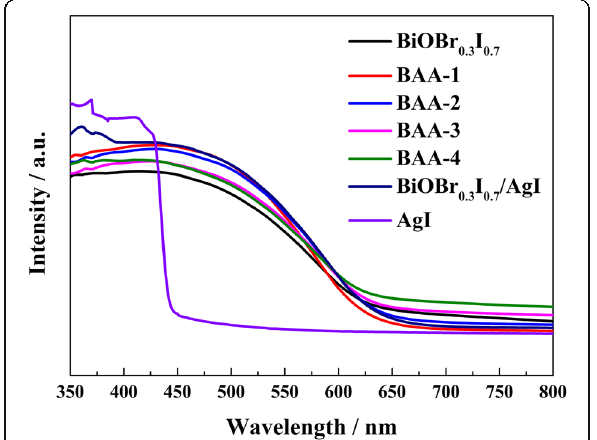
Fig. 3 UV – vis DRS spectra of BiOBr 0.3 I 0.7 , BAA- x , and BiOBr 0.3 I 0.7